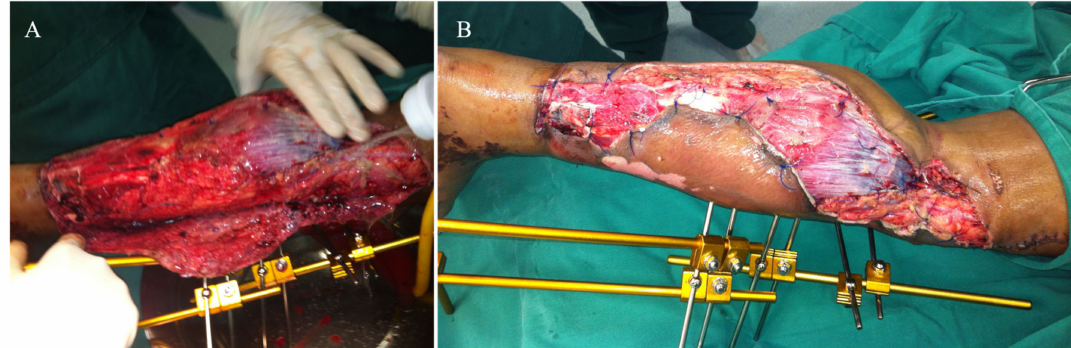
Figure 2. ( A ) The open wound was initially debrided, and a half-pin spanning external fixator was applied on the anterior aspect of the left lower limb, with the knee in slight flexion (approximately 10 ◦ ) and the ankle in neutral position. ( B ) After identification of the complete transection in the middle part of the popliteal artery, vascular surgeons performed direct vessel reconstruction with an end-to-end repair, and the skin flaps were loosely approximated and sutured to the gastrocnemius